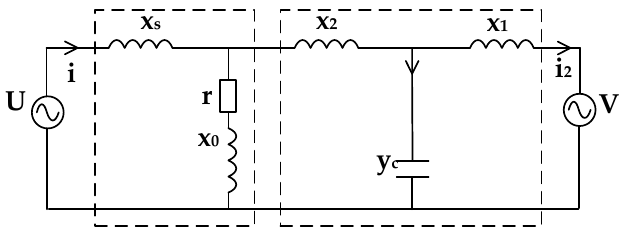
Figure 4. Two-port network for simplified power electronics-based AC power system. The loop circuit equation of two-port network is shown in the following: